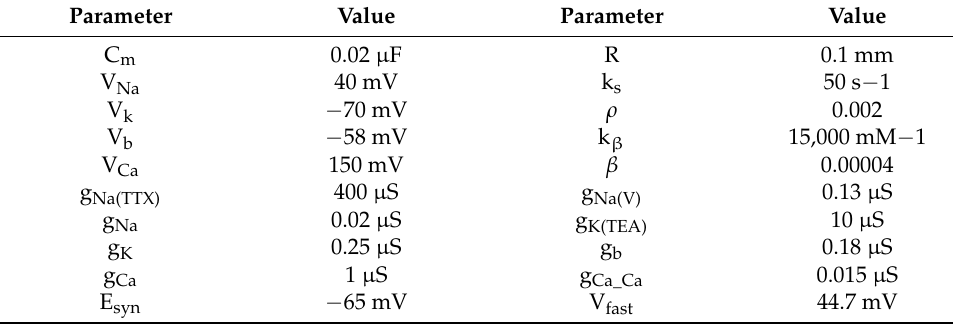
Table A1. Parameter values for the neuron